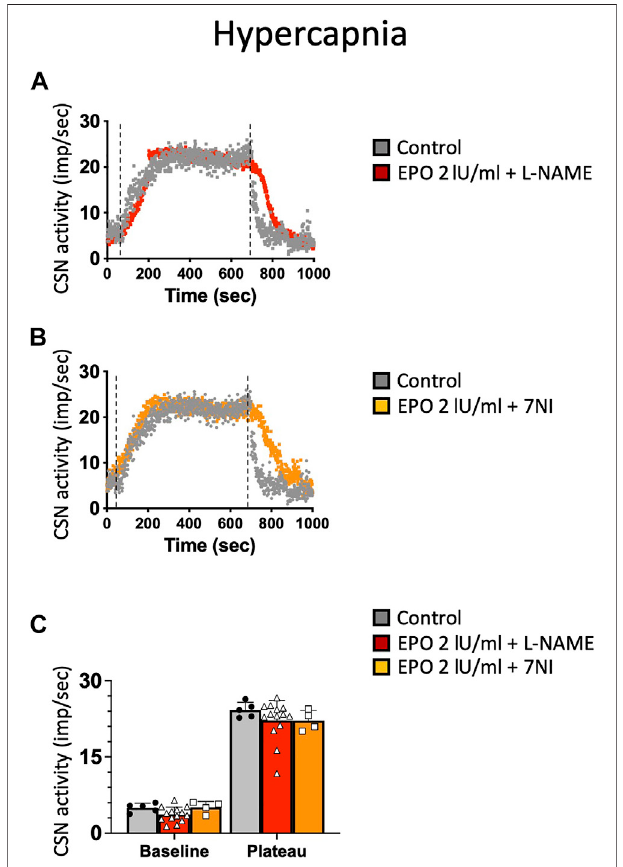
FIGURE 6 | (A) non-speci fi c (L-NAME) and (B) neuronal-speci fi c (7Ni) inhibitors of NOS prevented EPO-mediated inhibition of carotid sinus nerve (CSN) hypercapnic activity at a concentration of 2 IU/ml. (C) RM Two-way ANOVA F (2, 20) (cid:1) 0.424 p (cid:1) 0.66. Dashed lines indicate the beginning and end of the hypoxic